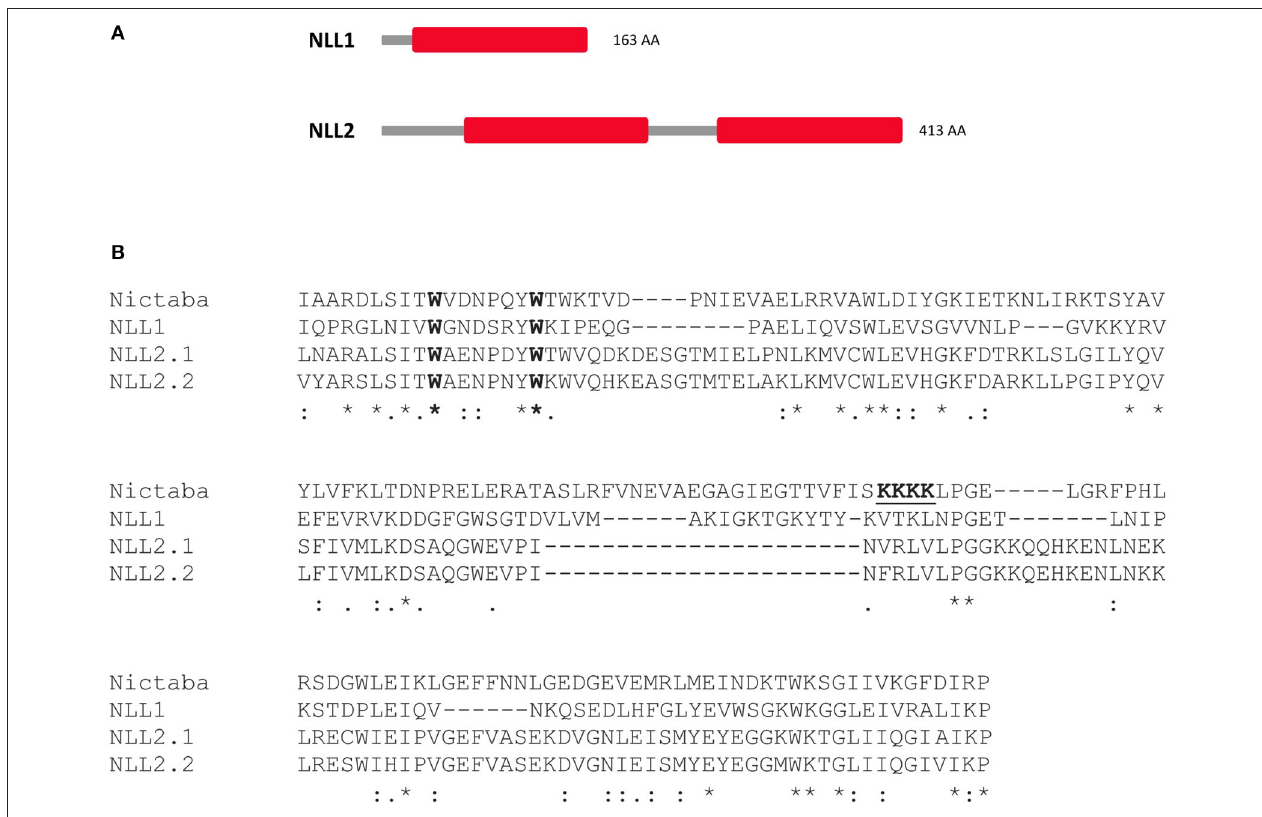
FIGURE 1 | (A) Domain architecture of the Nictaba-like homologs from soybean under study: NLL1 ( Glyma.06G221100 ) and NLL2 ( Glyma.20G020900 ) (B) Sequence alignment of the trimmed Nictaba sequence and the Nictaba domains of NLL1 and NLL2 (NLL2.1: domain one, NLL2.2: domain two) from soybean using ClustalO. The conserved Trp-residues important for the carbohydrate-binding activity of Nictaba are marked in bold and the proposed nuclear localization signal of Nictaba is underlined. ‘*’indicates fully conserved amino acid residue; ‘:’designates conserved amino acid substitution (indicating conservation between groups of strongly similar properties); ‘.’designates semi-conserved amino acid substitution (indicating conservation between groups of weakly similar